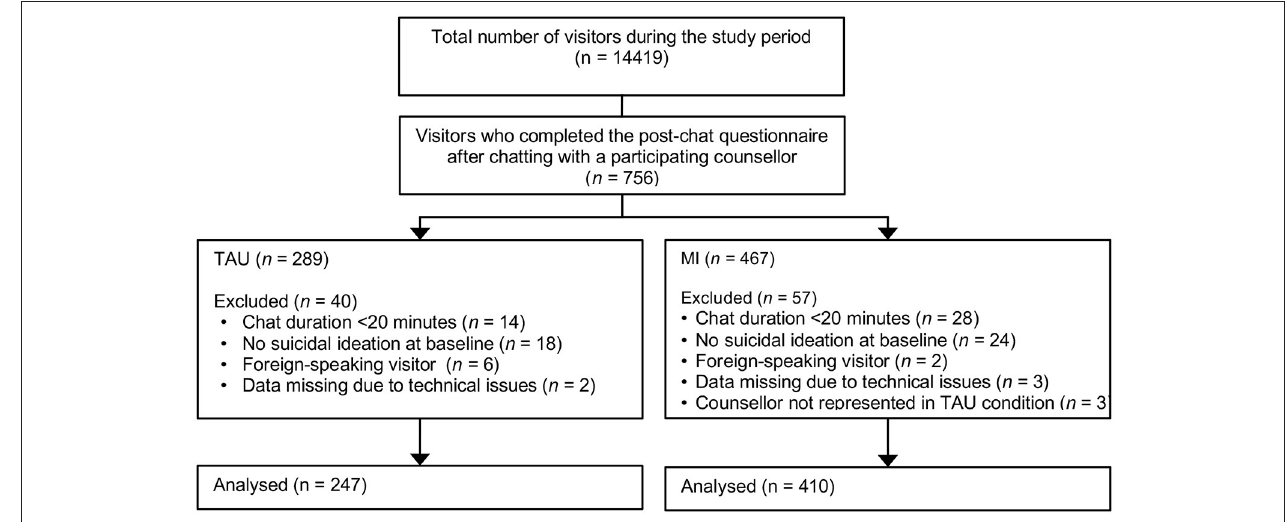
FIGURE 2 | Participant flowchart.